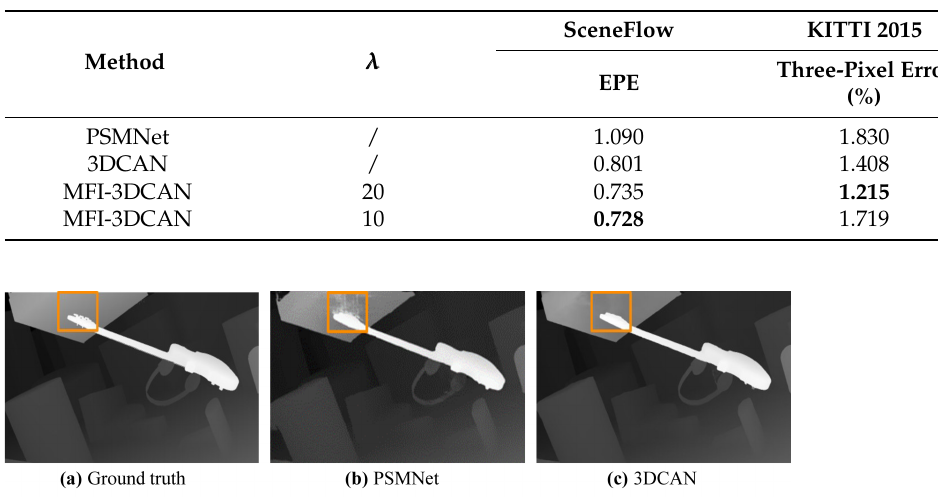
Figure 9. Qualitative result of 3DCAN. ( a ) is the ground truth, ( b ) is the result of baseline model, and ( c ) is the disparity result of our method with